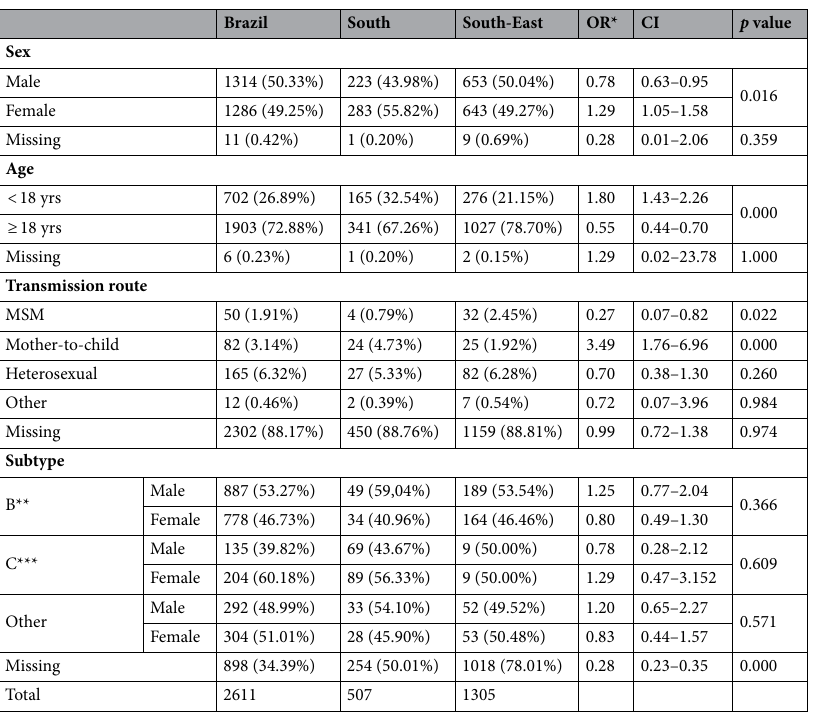
Table 2. Epidemiological comparison of HIV-1 epidemics between South and South-East Brazil. *The OR, CI and p value are presented for the South versus South-East comparison using two-tailed Fisher Exact Test or Corrected Mantel–Haenszel chi-square test were applicable. **For the difference in the prevalence of subtype B between men and women in Brazil, the following statistical result was found: OR = 1.36, CI = 1.15–1.59, p = 0.000. ***For the difference in the prevalence of subtype C between women and men in Brazil, the following statistical result was found: OR = 1.64, CI = 1.30–2.08, p =